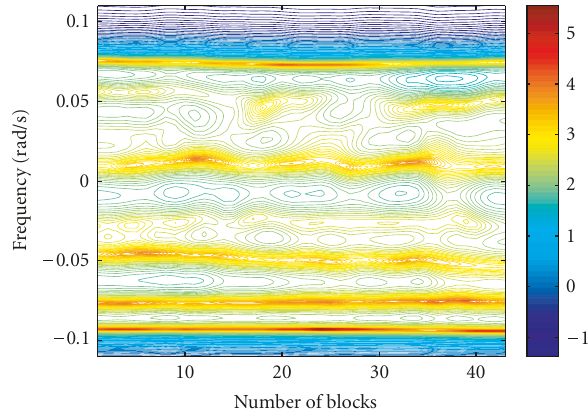
Figure 2: Example of a MUSIC pseudospectrum of a measurement in an urban area. A number of high-power frequency bins can be observed. They are distributed on both the positive and negative sides of the spectrum. But the relative power between these bins and the remaining frequency bins is low. Those bins close to the posi- tive and negative maximum Doppler frequencies are more consis- tent over the measurements than the others. These bins have blurry edges.